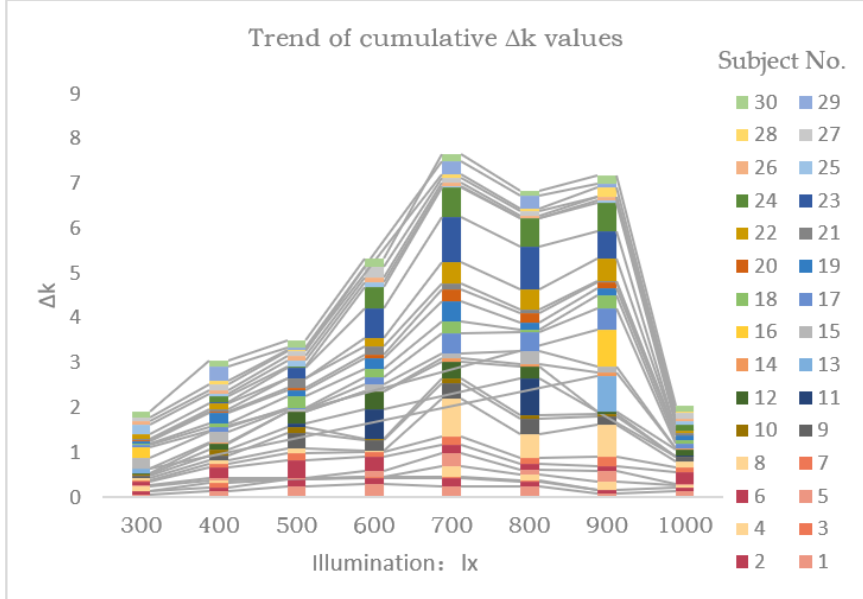
Table 7. Cumulative Δk value result .